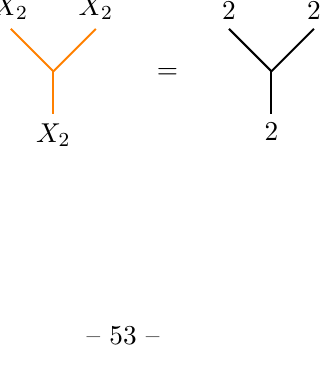
Figure 10 . The even fusion channel X ⊗ Y → Z is identified with the corresponding bulk fusion channel. The odd fusion channel X ⊗ Y → Z is identified with the bulk fusion channel decorated by a fermion line